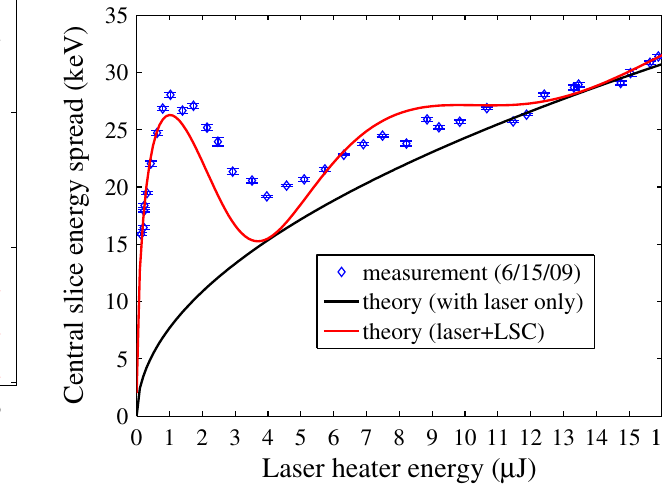
FIG. 11. (Color) Central slice rms energy spread vs LH energy in the trickle heating